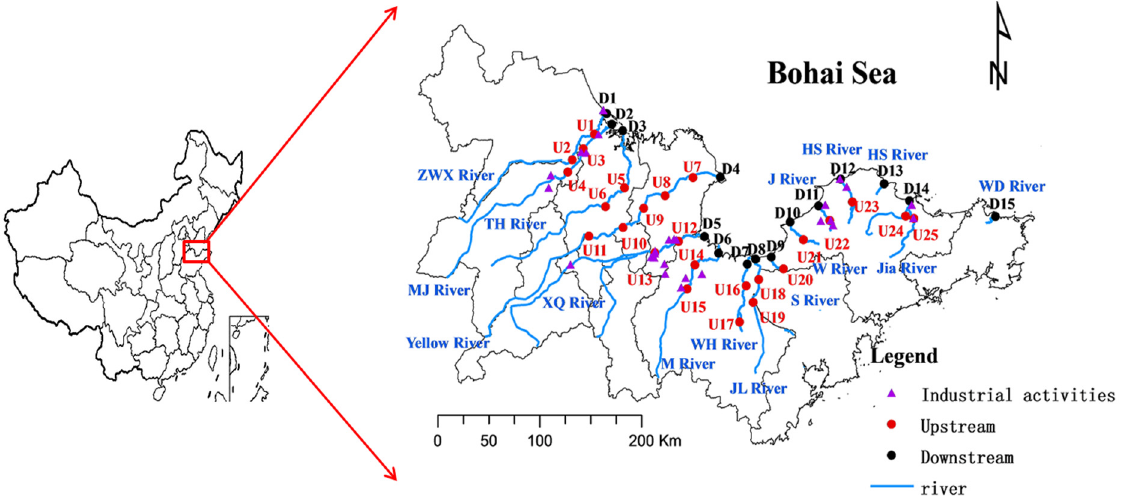
Figure 1. Sampling sites along the watershed of the Bohai Sea (upstream sampling sites are labeled U1 to U25, and downstream sites are labeled D1 to